Question: Identify the chart type used in this figure.
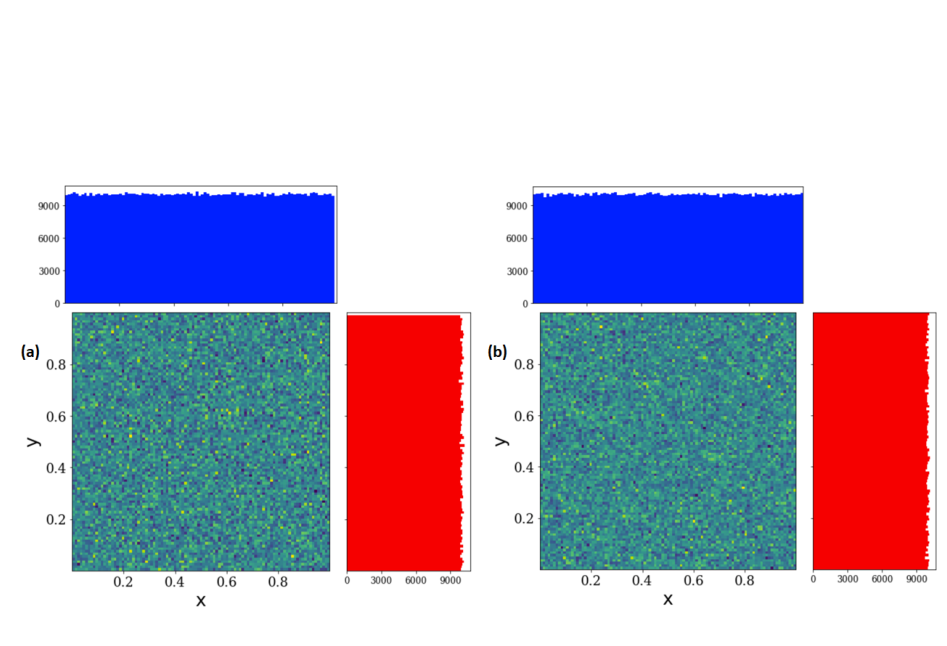
Answer: histogram